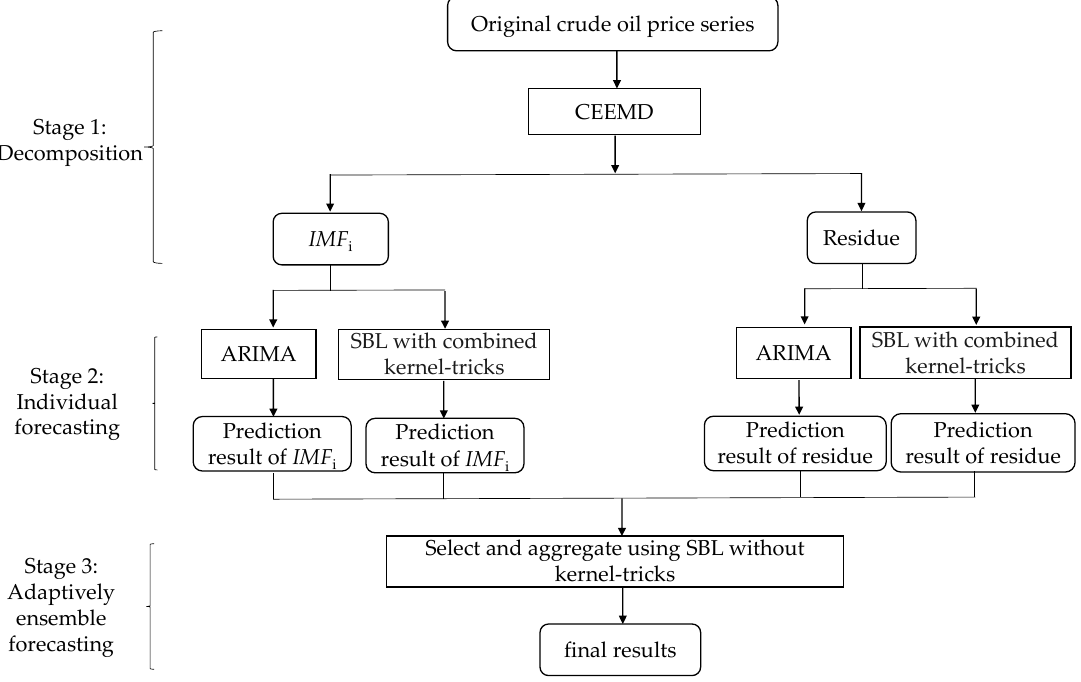
Figure 1. The flowchart for the CEEMD-A&S-SBL. CEEMD: complete ensemble empirical mode decomposition; A&S: autoregressive integrated moving average (ARIMA) and sparse Bayesian learning (SBL); SBL: sparse Bayesian learning.